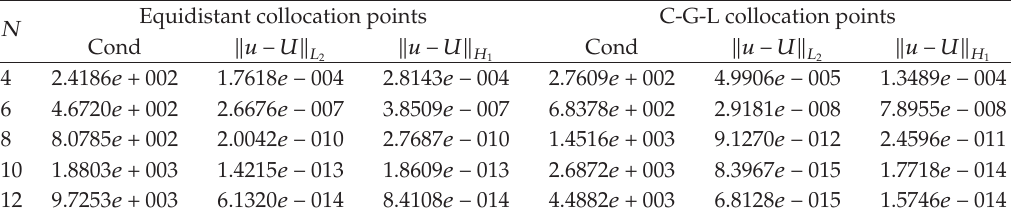
(cid:4) 10, β (cid:4) 100 (cid:6) . 1 2